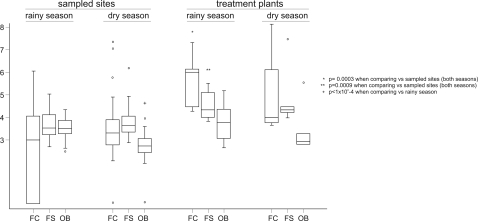
Box and whiskers plots of results of microbiological analyses of Xochimilco area irrigation by season and site.Bacterial counts are shown in a log10 scale; empty circles denote outliers.